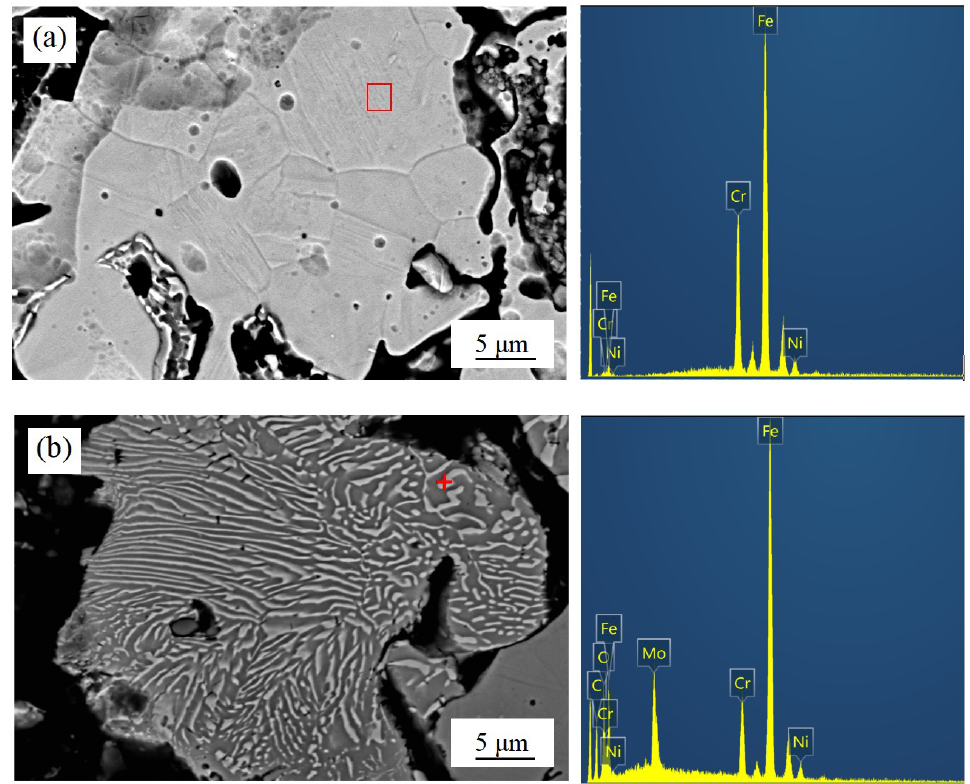
Figure 15. Microstructure of porous 316 stainless steel; ( a ) austenite grain; and ( b ) σ phase; the energy spectrum analysis is on the right side of the back-scattered electronic image.